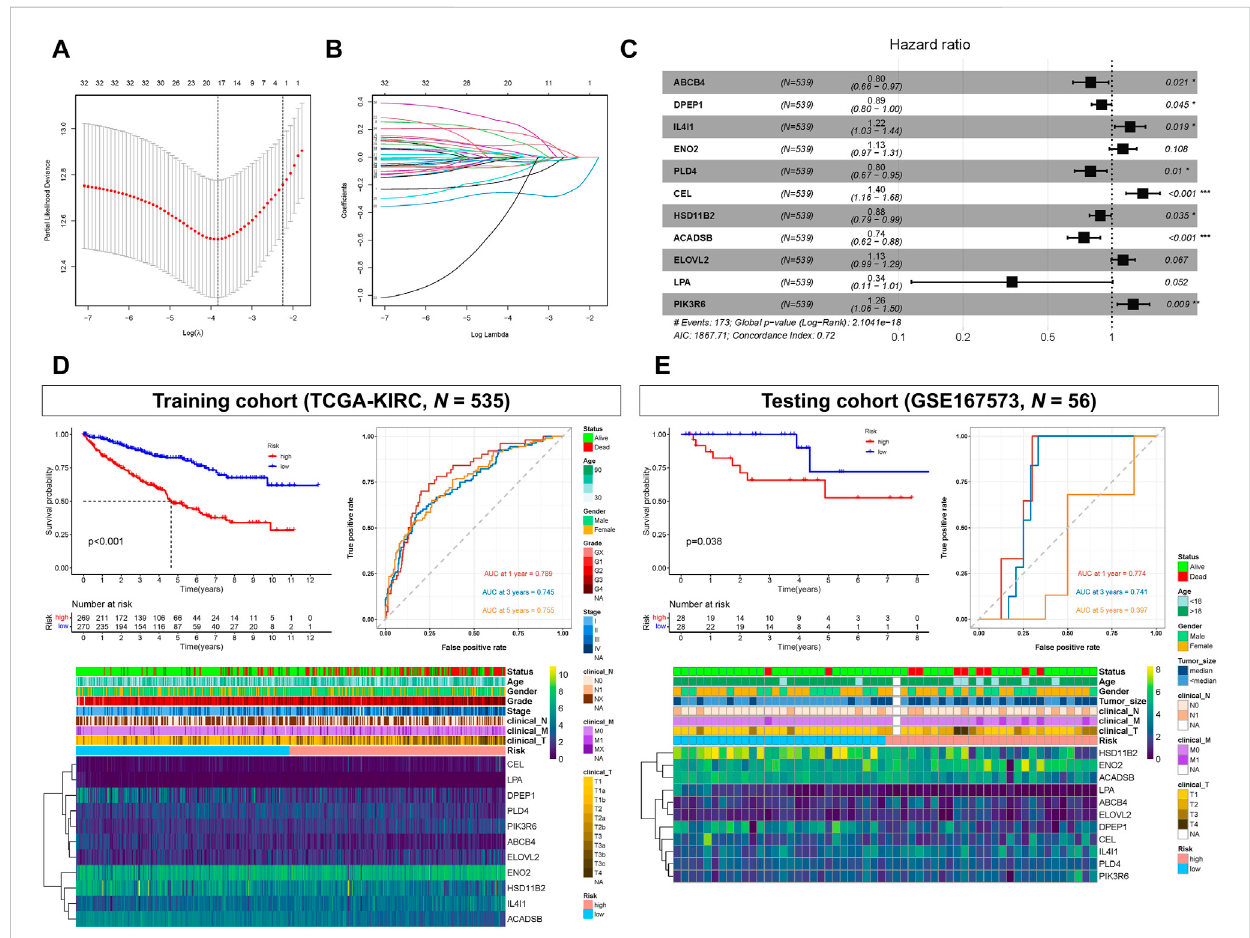
FIGURE 3 Prognostic model constructed based on lipid metabolism genes (LMGs). (A, B) Least absolute shrinkage and selection operator (LASSO) regression complexity (controlled by lambda using the R package “ glmnet ” ). (C) Multivariate analysis of risk LMGs in clear cell renal cell carcinoma (ccRCC). (D) Survival and receiver operating characteristic (ROC) analyses between high- and low-risk score groups in the training cohort (TCGA-KIRC). (E) Survival and ROC analyses between high- and low-risk score groups in the testing cohort